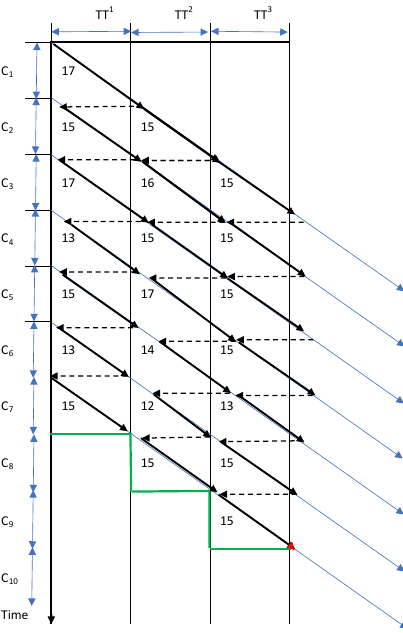
Figure 2. The diagram of employee movement with predicted (C = 15) and real cycle times (12, 13, 14, 15, 17), the product disassembly cycle time is equal to the transport cycle time (TT = 15).